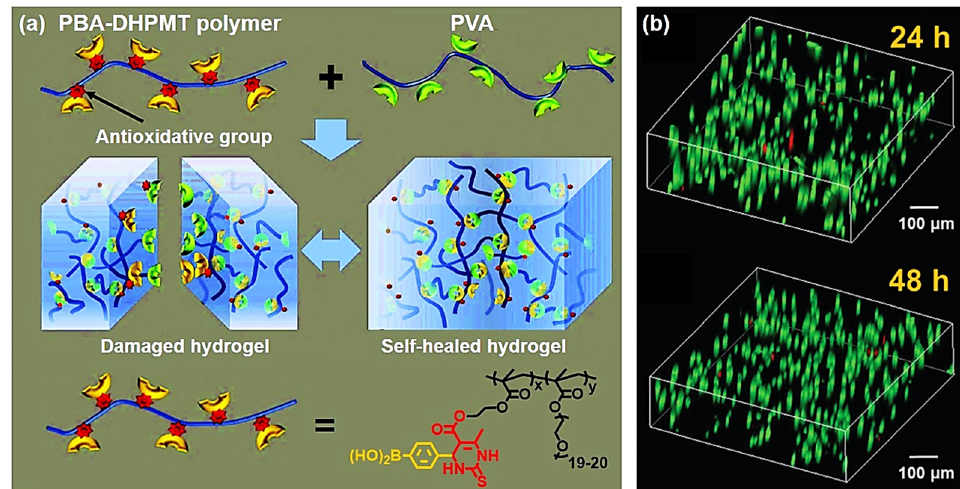
Figure 5. An antioxidant self-healing hydrogel produced via the Biginelli reaction. ( a ) The preparation of the antioxidant hydrogel based on the dynamic borate ester bonds and its self-healing property; ( b ) FDA/PI double-staining of L929 cells in the 3D hydrogel culture matrix ( top : 24 h; bottom : 48 h). Reprinted with permission from ref. [63]. Copyright © 2020 Royal Society of Chemistry. All rights reserved.